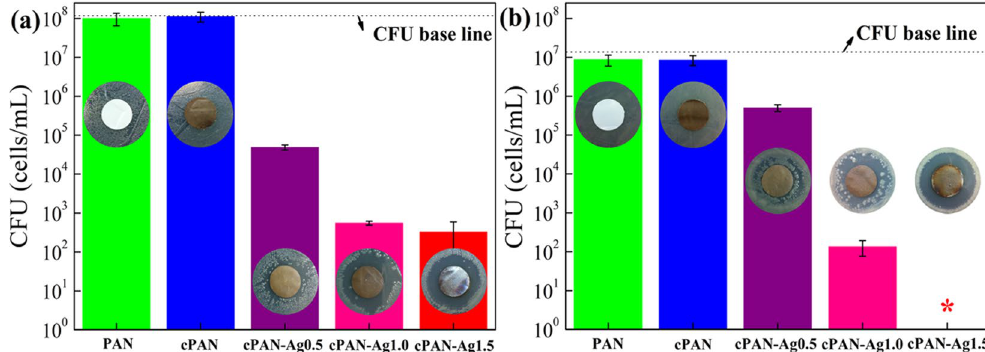
Figure 4. Antibacterial tests (colony forming units and diffusion inhibition zones) for different membranes. Gram-negative E. coli ( a ) and Gram-positive B. subtilis ( b ) were used as the model bacteria. The symbol “ * ” stands for below detection